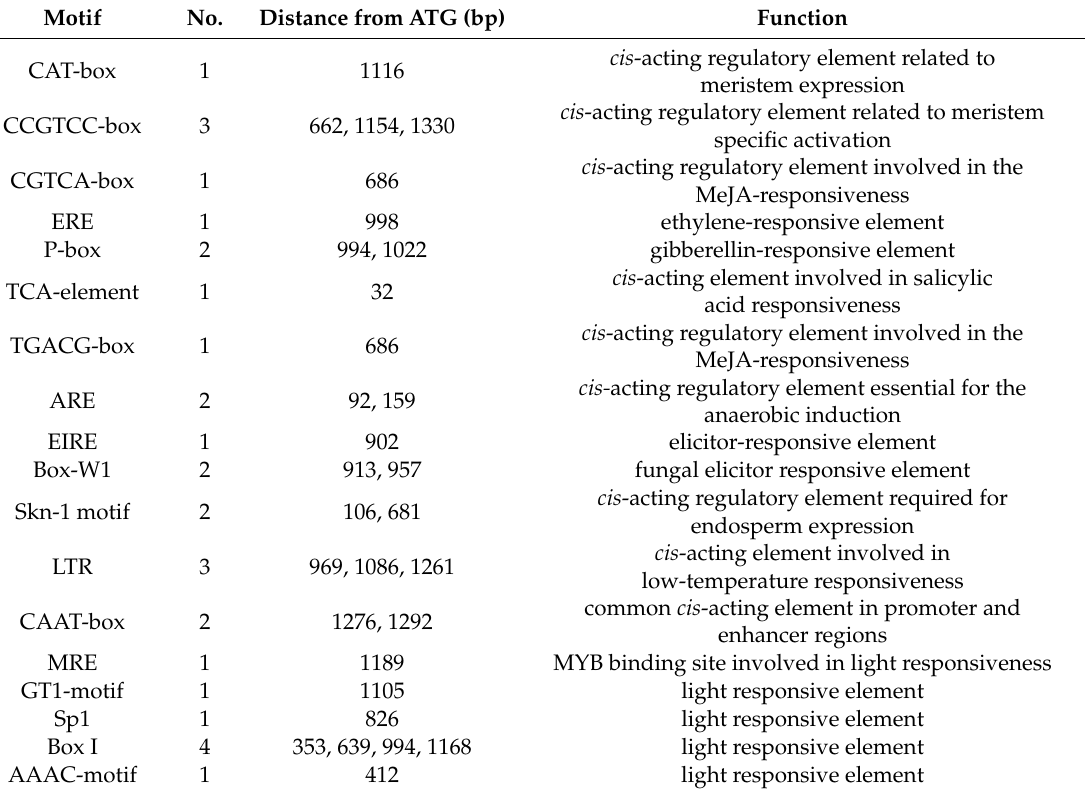
Table 1. An in silico analysis of the regulatory element content of the CnTCP4